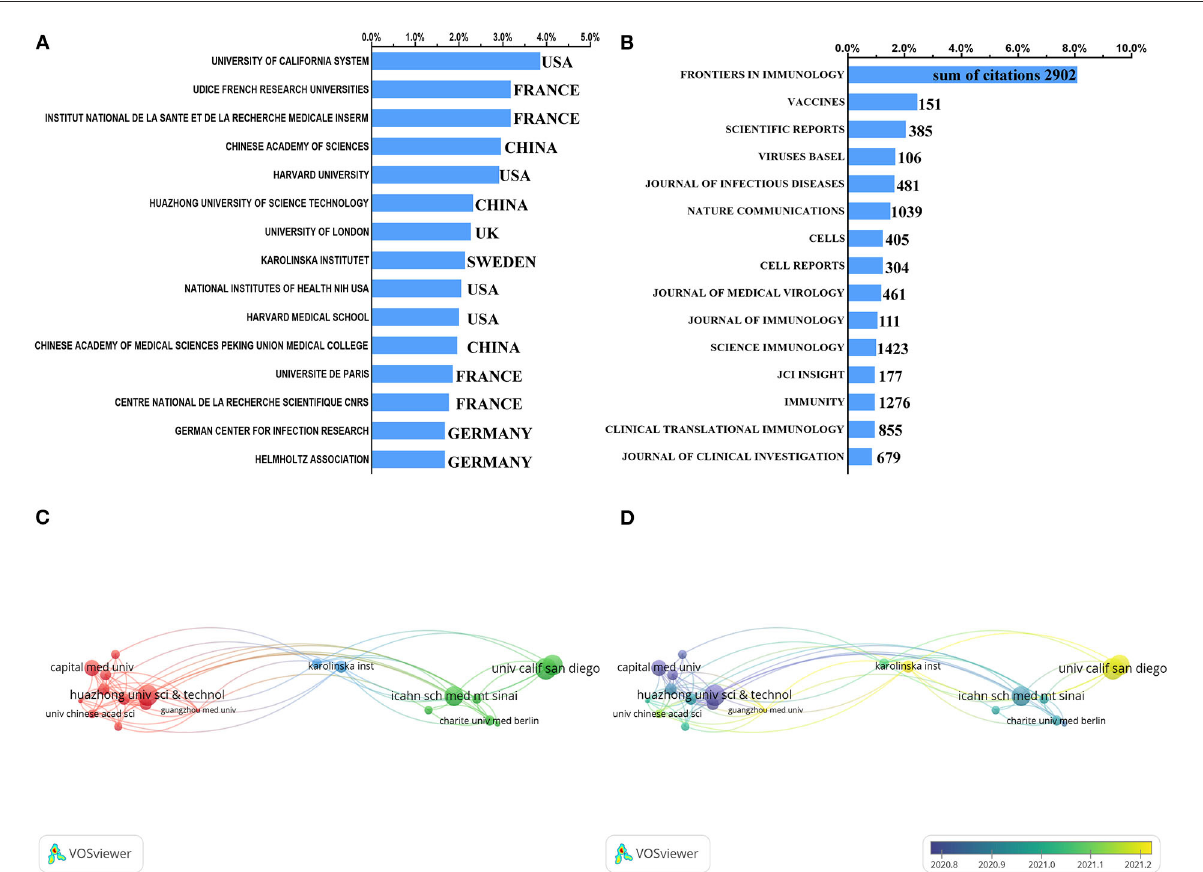
FIGURE3 Institutions and journals publishing articles on COVID-19 and immune response. (A) Top 15 institutions with the most publications on immunization and COVID-19. (B) The ranking list of global journals publishing the most articles on immunization and COVID-19. The X-axis represented the percentage of the published number of each institution or journal to the total number of publishments. (C) The co-authorship network of top 20 institutions, and per institution had more than 20 publications with international cooperation. (D) The top 20 institutions were shown in chronological order of